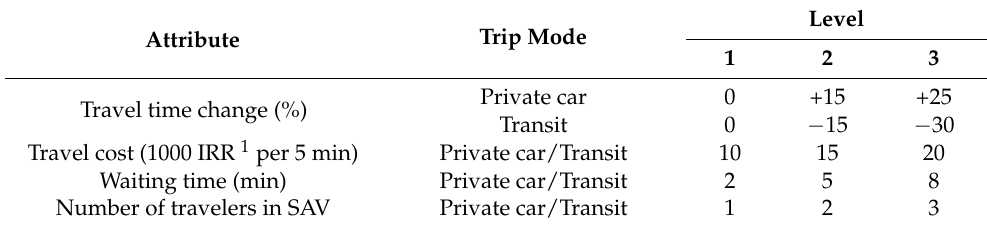
Table 2. Stated preference attributes and their levels across private car and transit